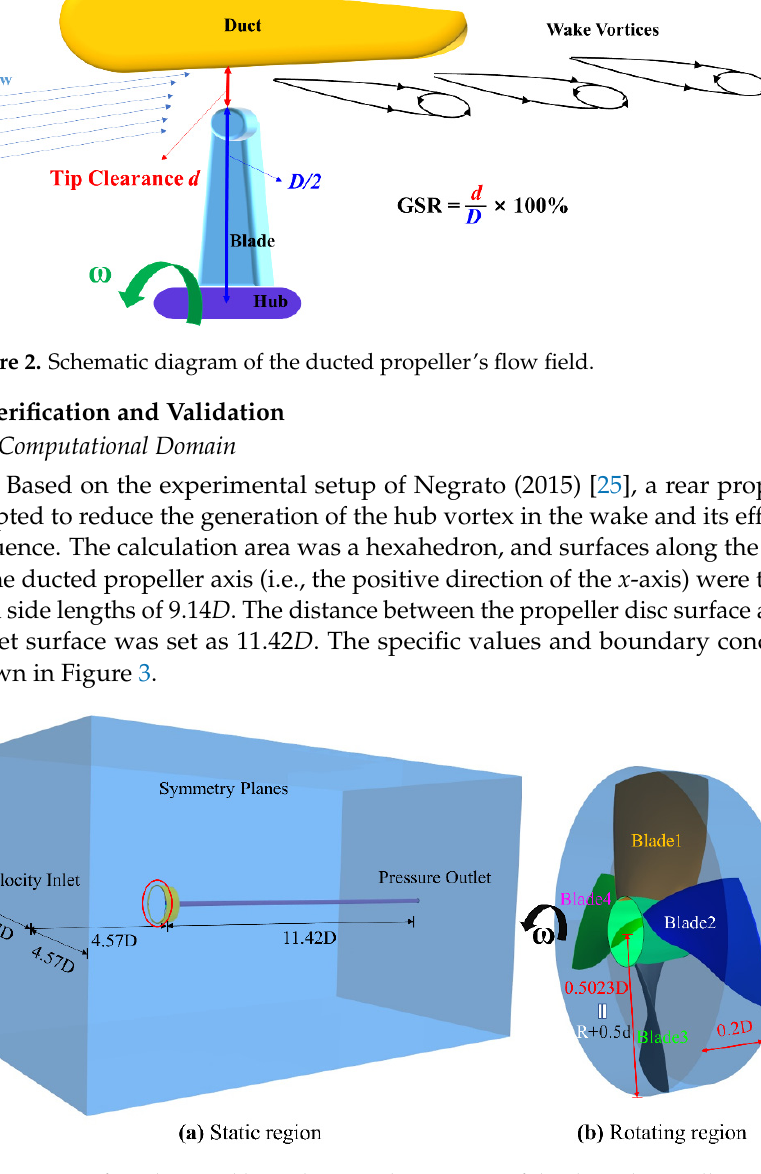
10.2 Figure 4. Five groups of propeller blade surface meshes.